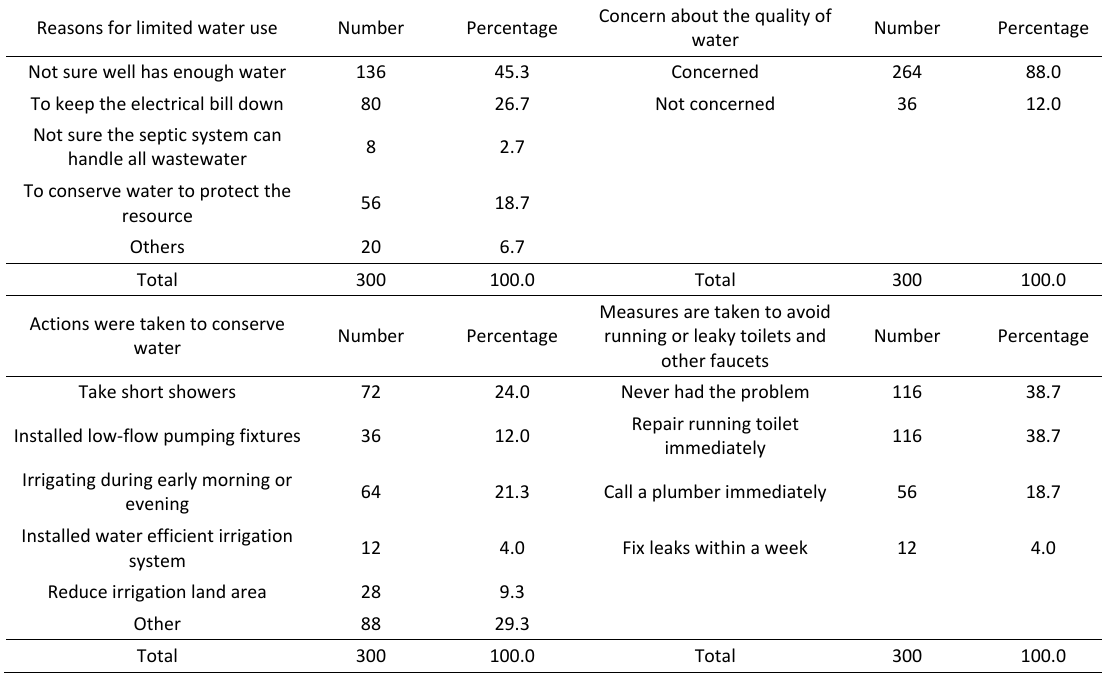
Table 6: Linear regression analysis